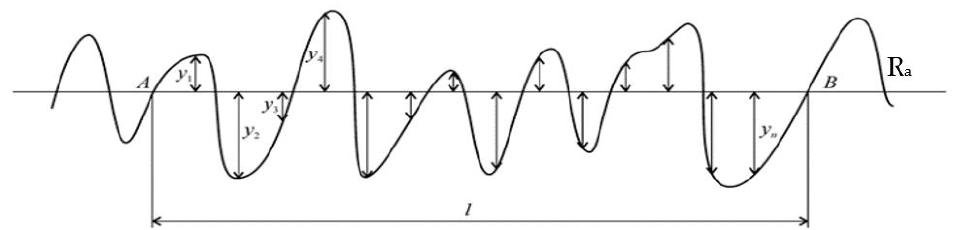
Figure 3. A typical tool wear, V